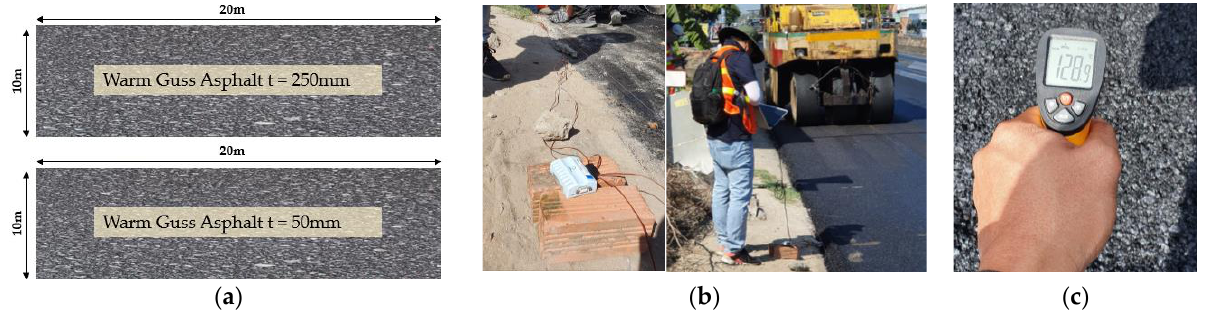
Figure 11. ( a ) Field testbed section, measurement of the WGA surface by using instrument ( b ) and thermal meter ( c ).